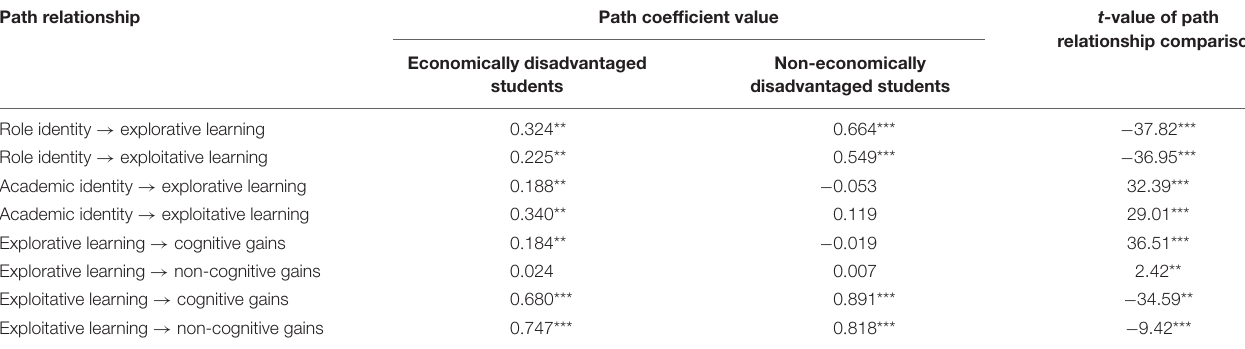
TABLE 3 | Path relationship comparison between economically disadvantaged and non-economically disadvantaged students. Path relationship Path coefficient value t- value of path